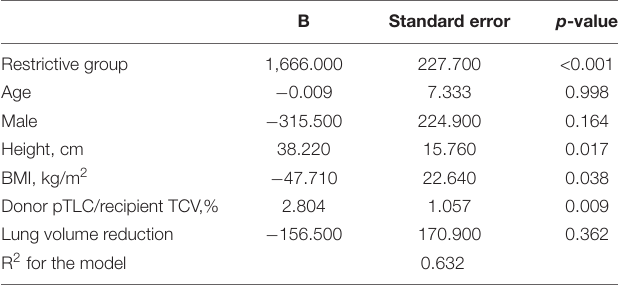
B Standard error p